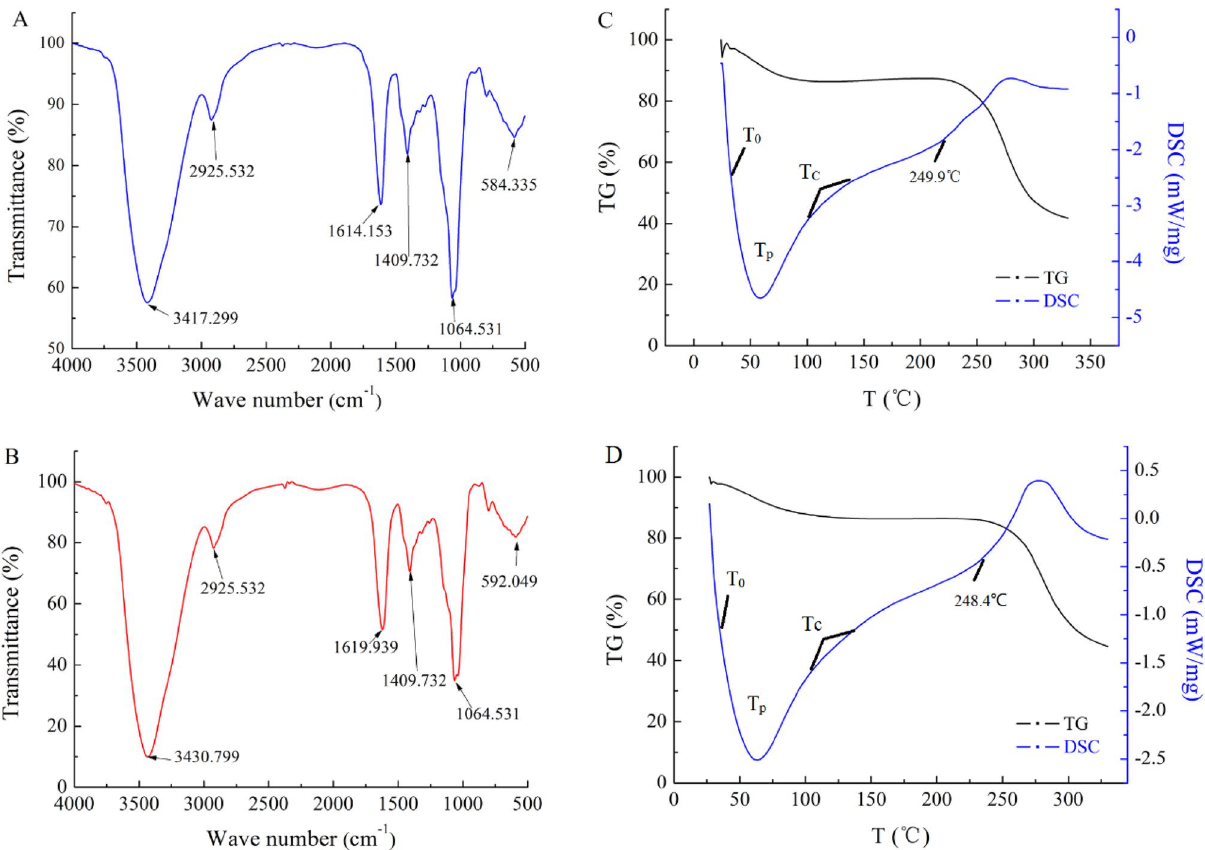
Figure 3. FT-IR spectra of HNCP3 ( A ) and UNCP4 ( B ). (NCP are Nostoc commune polysaccharides). DSC detects HNCP3 ( C ) and UNCP4 ( D